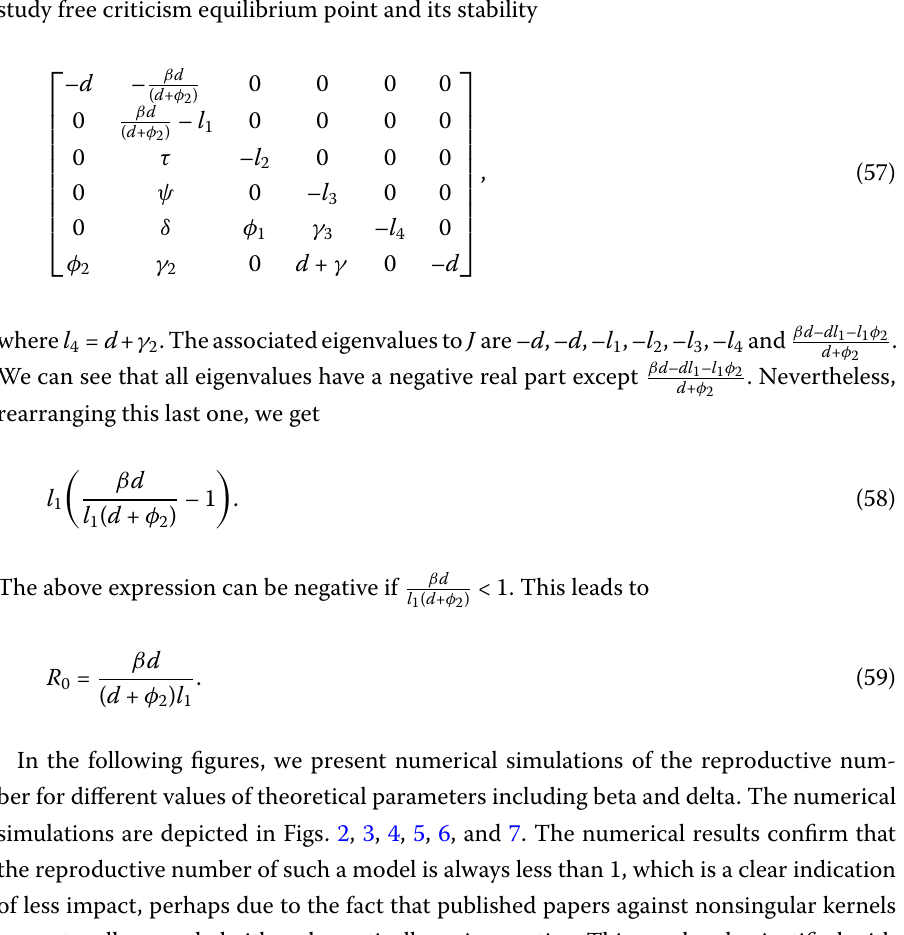
study free criticism equilibrium point and its